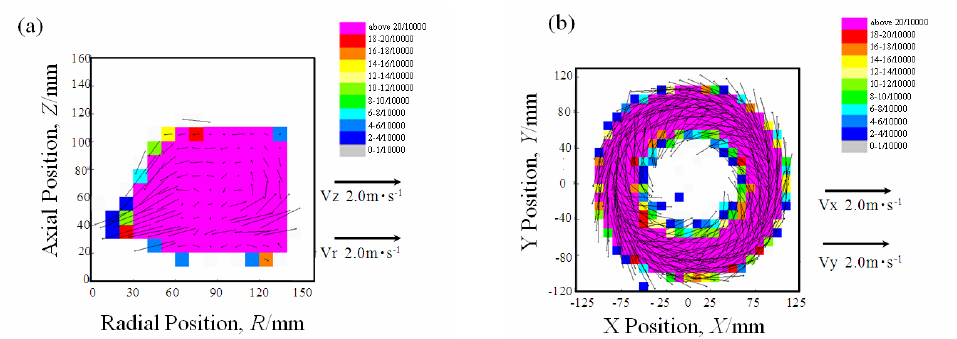
Fig.3 Particulate motion within the mixer using a flat blade, impeller speed =600